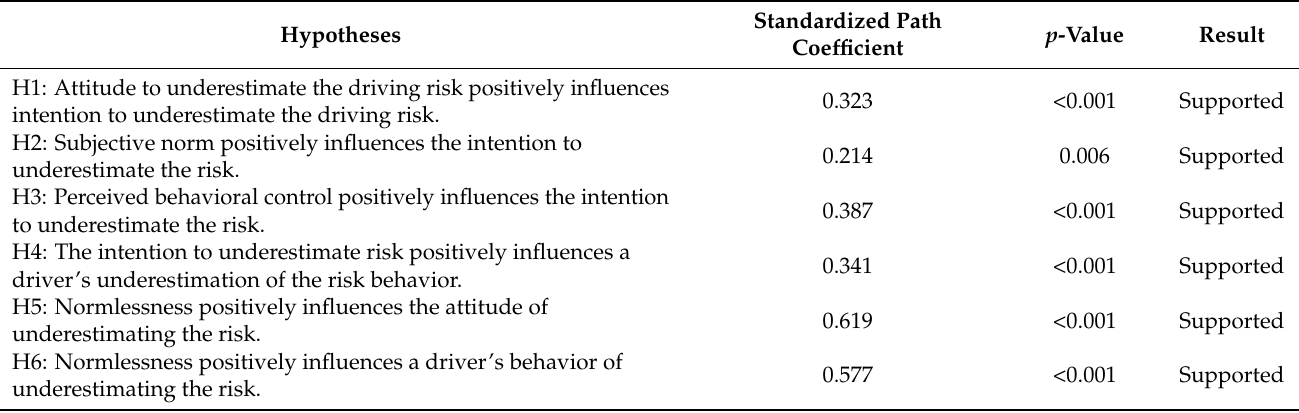
Table 7. Results of hypothesis testing.